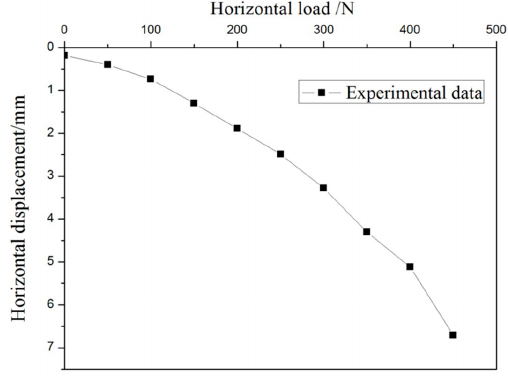
Figure 3. The curve of the pile’s load–displacement under lateral load.